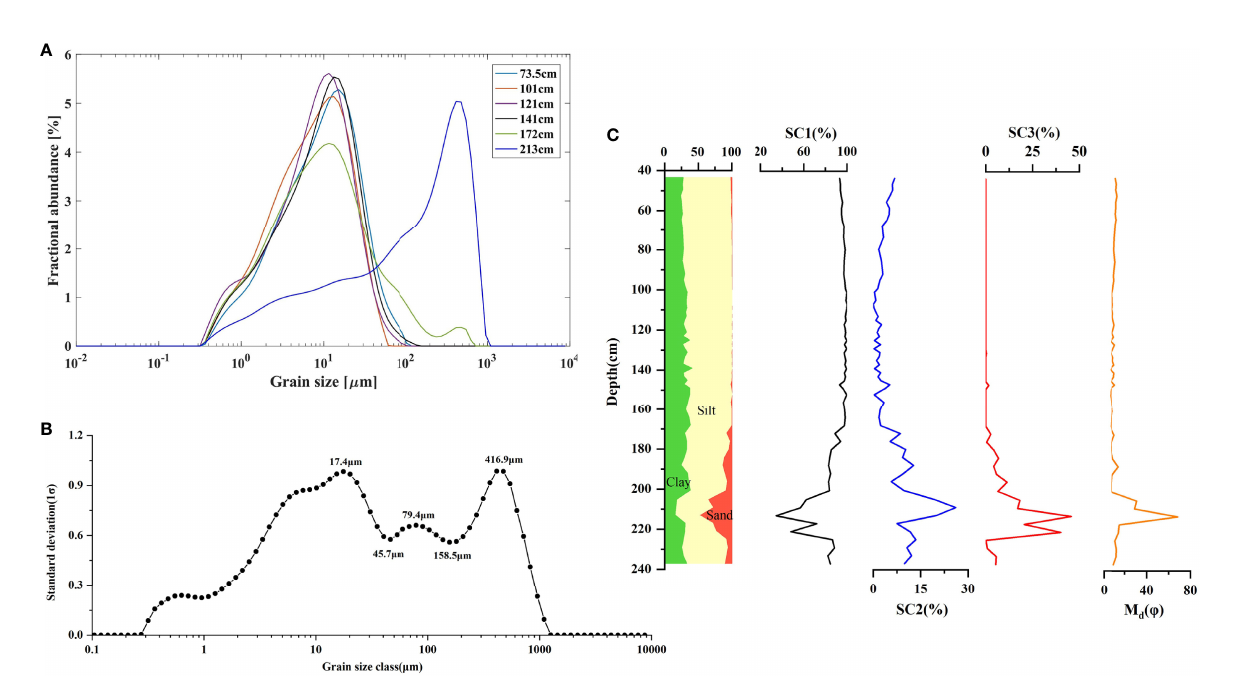
FIGURE 4 | Grain size analysis results in the GGL section. (A) Grain size frequency curves at different depths; (B) Grain size classi fi cation with standard deviation diagram; (C) Depth variation of the three grain size sensitive components expressed as relative